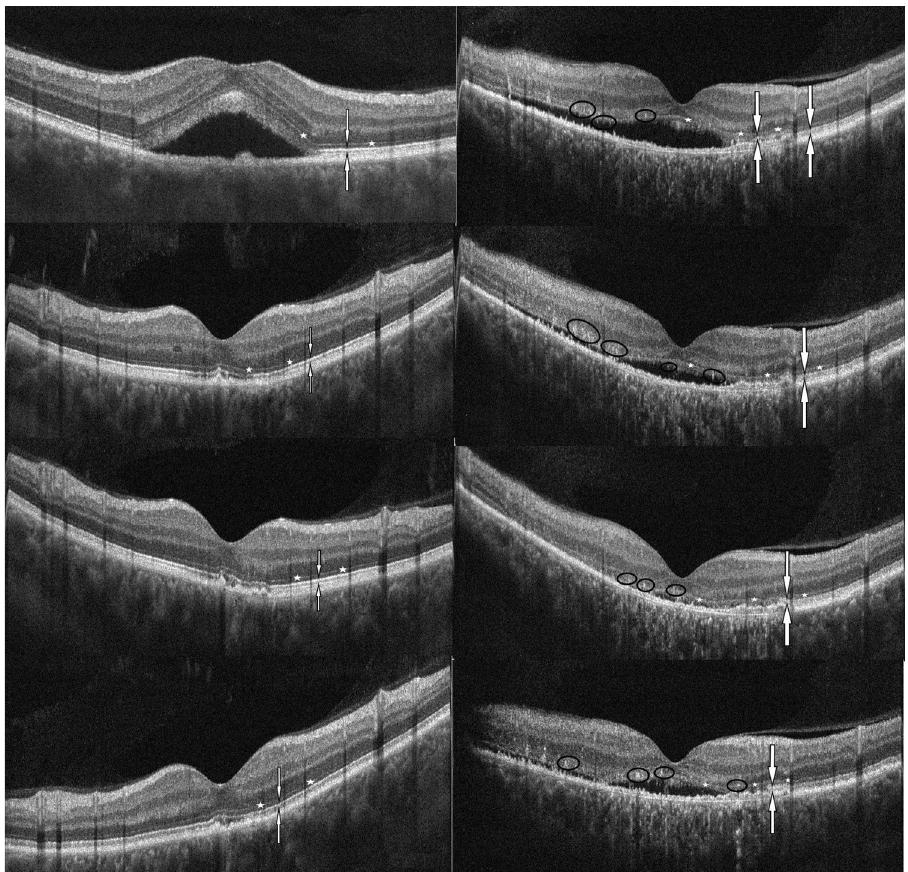
Figure 2. OCT images of good responder to eplerenone at 0, 3, 6 and 12 months: baseline SRF was absorbed after 3 months therapy and did not reoccure:ellipsoid is intact (line between white arrows), ELM is intact (little white stars) (left images from top to bottom). V OCT images of poor responder to eplerenone at 0, 3, 6, and 12 months: ellipsoid zone is interrupted (line between white arrows), hyperreflective foci in the OS and ON layer, ELM is slightly damaged (little white stars) (right images from top to